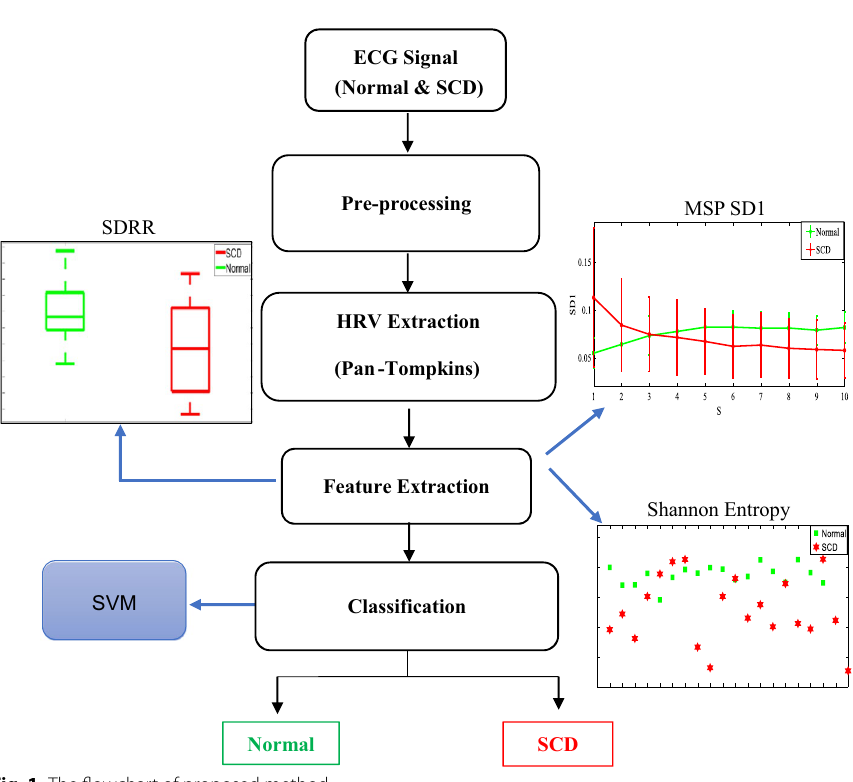
Fig. 1 The flowchart of proposed method